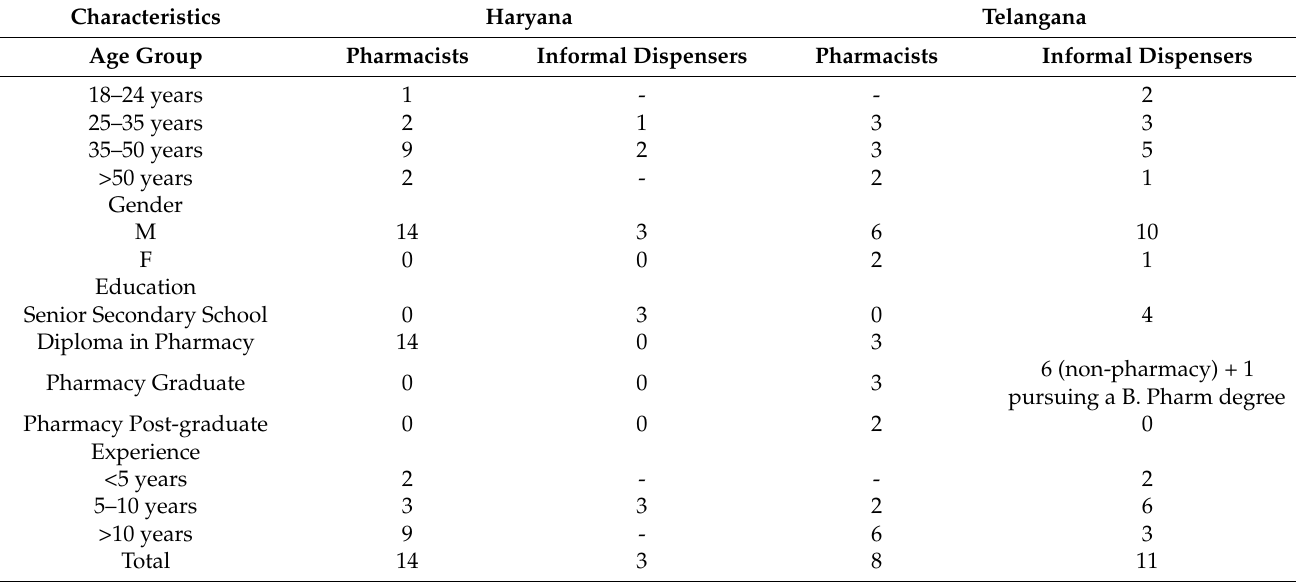
Table 1. Demographic details of respondents at retail pharmacies in Haryana and Telangana.